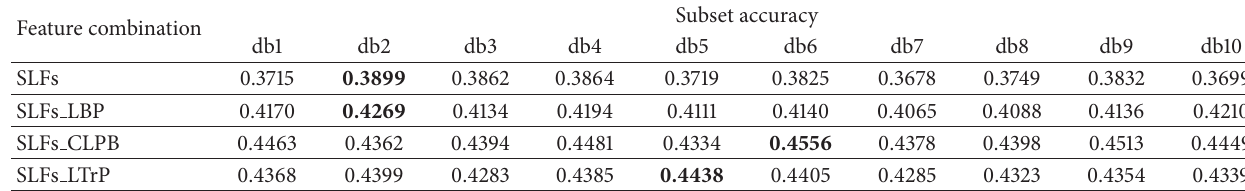
Table 3: Comparison of subset accuracies with different local pattern